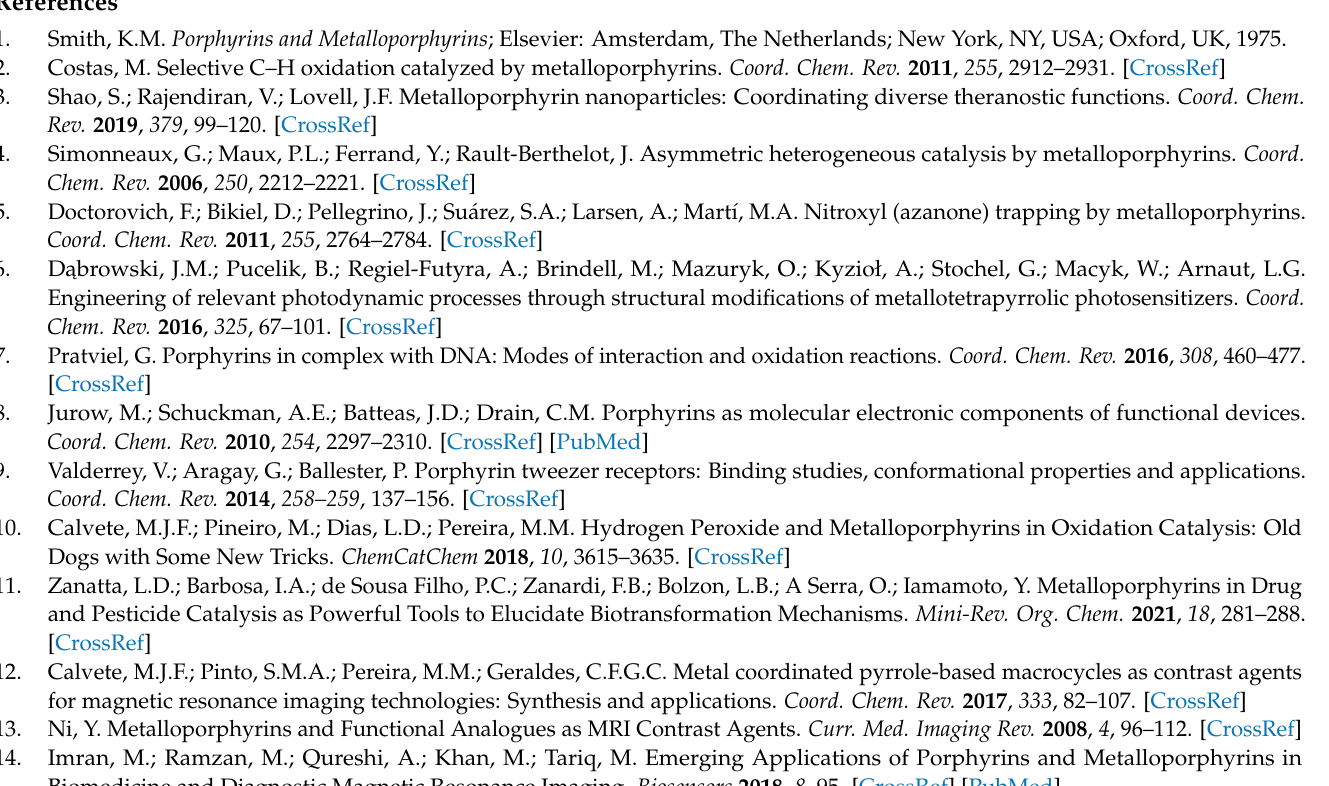
Table S4: E-factor for the synthesis of Cu(II) complexes of 3-OHTPP, Table S5: Data for Ecoscale calculation